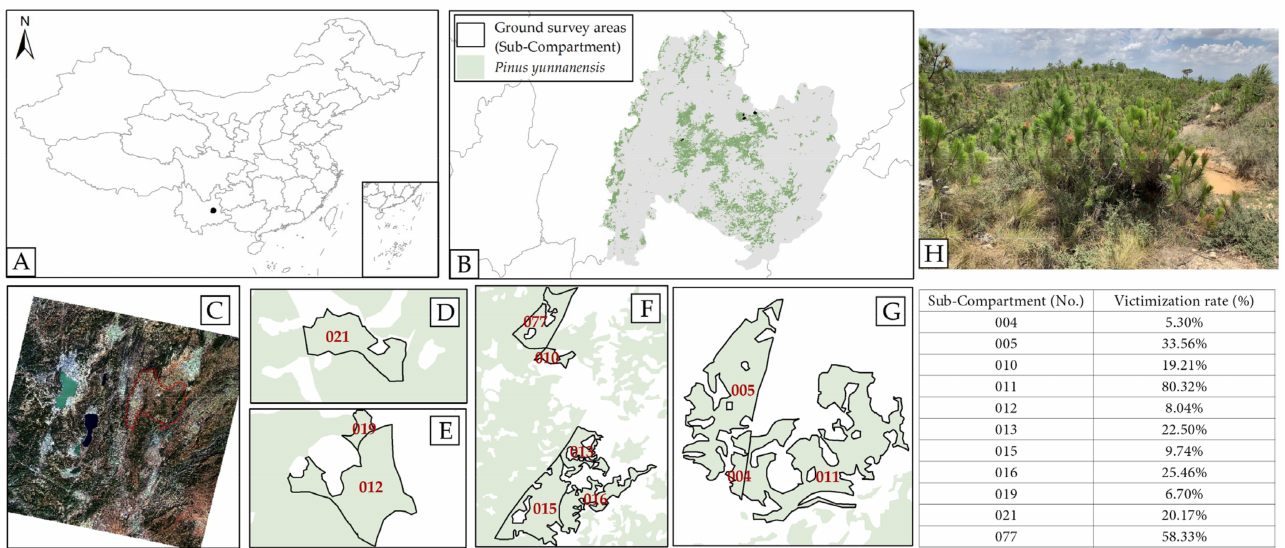
Figure 1. Diagram of the study area. ( A ) Shilin in China; ( B ) Pinus yunnanensis forests in Shilin; ( C ) Landsat image with the study area; ( D – G ) Ground survey areas; ( H ) Yunnan pine forest (partial). Victimization rate = (The number of infested trees/Total number of trees) ×